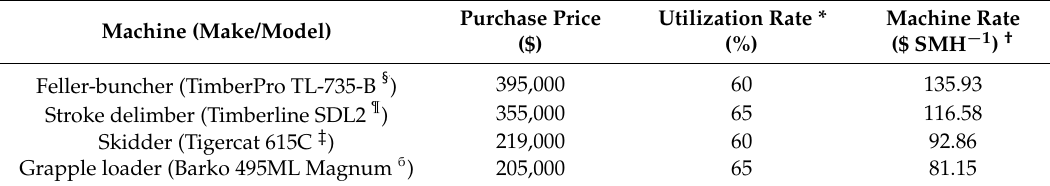
Table 2. Harvesting equipment purchase price, utilization rate, and machine hourly rate used for cost analysis in this study.